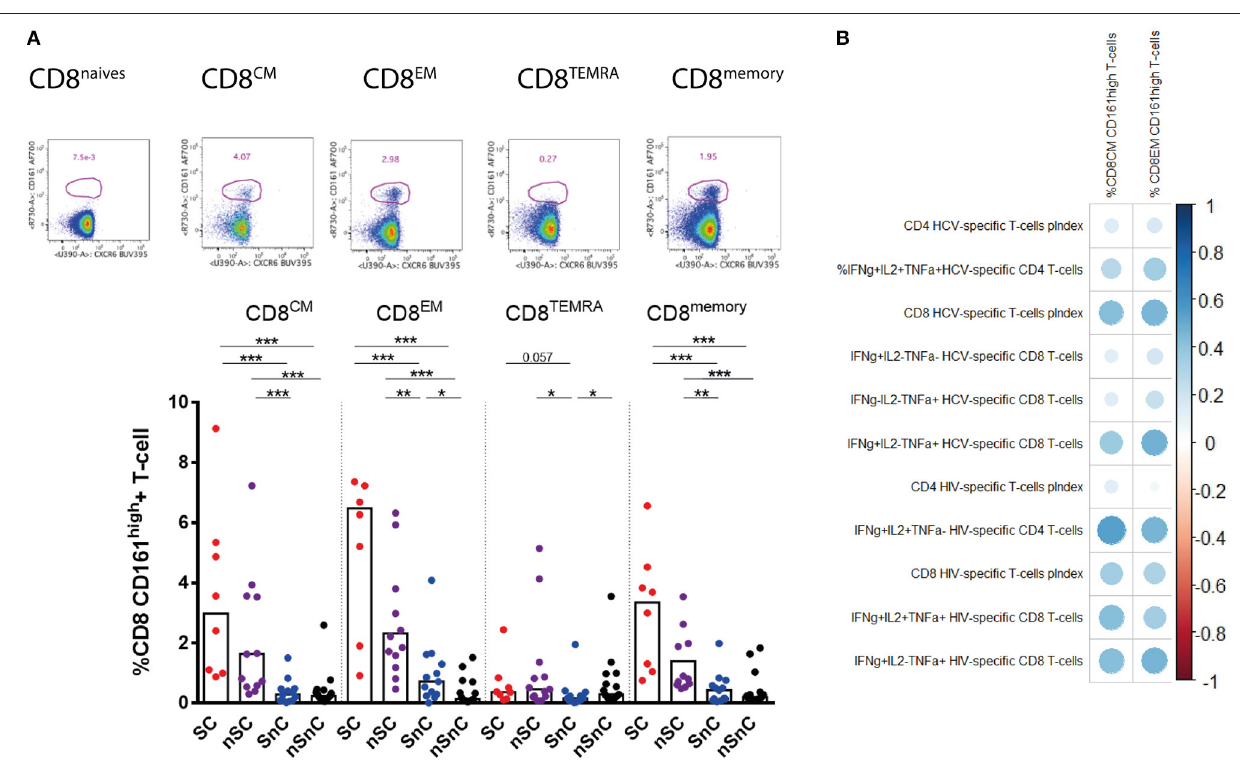
( Figure 7A ). No differences of NK CD56 high cells were found among groups ( Figure 7B ). In line with the results for CD4 and CD8 T-cell activation, HIV controller groups, SC and